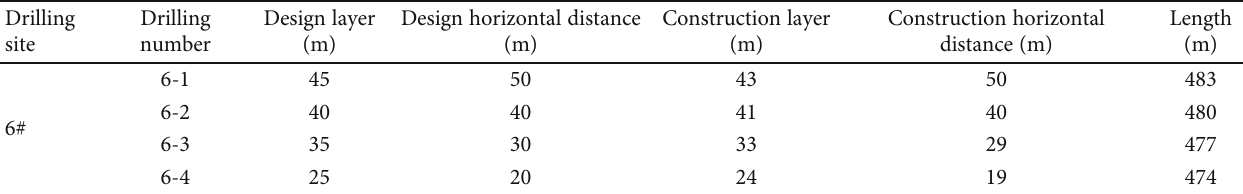
Table 3: Parameters of the high-level directional long